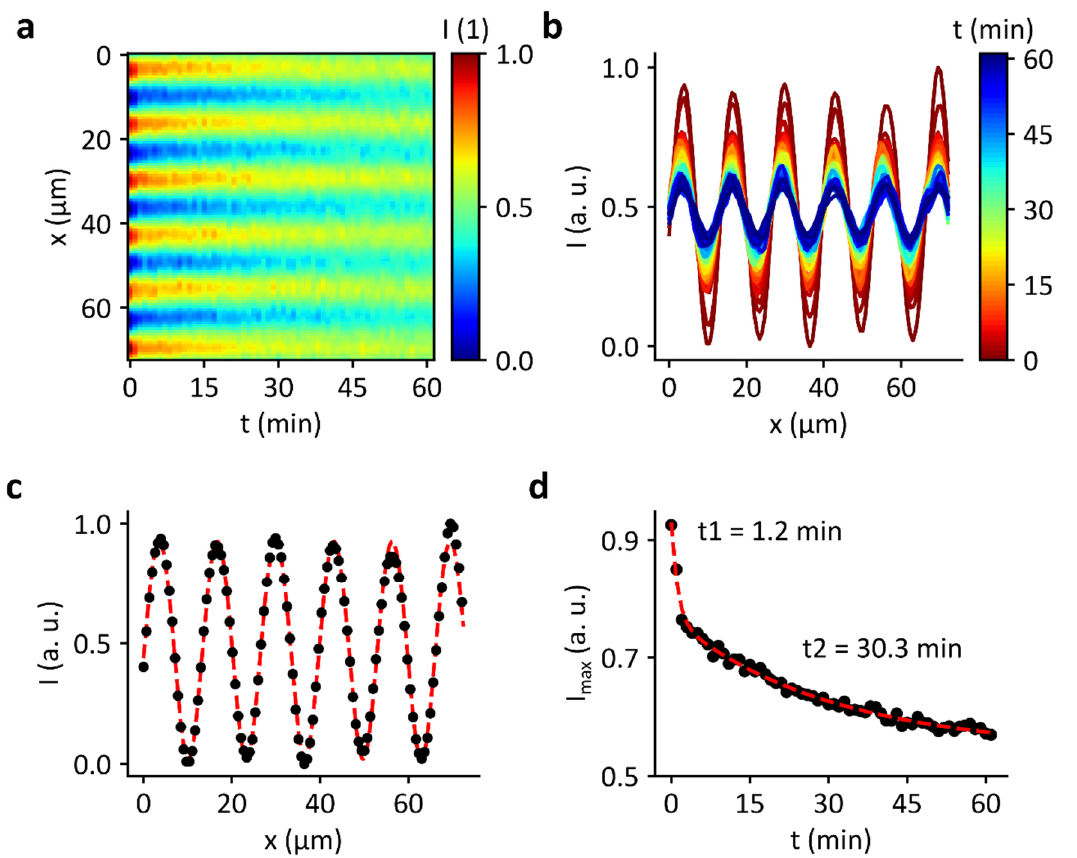
Figure 7. Domain decay in an SLB after switching off the RF signal inducing a SAW standing wave field. ( a ) Heatmap of the normalized brightness intensity over a period of 60 min. ( b ) Intensity profile perpendicular to the pattern of stripes. ( c ) Intensity course for t = 0 min with fit function according to Equation (5). ( d ) Dependence of the intensity maximum as a function of time after switching off the SAW. The intensity decreases with time. However, the stripe pattern is still visible after one hour.